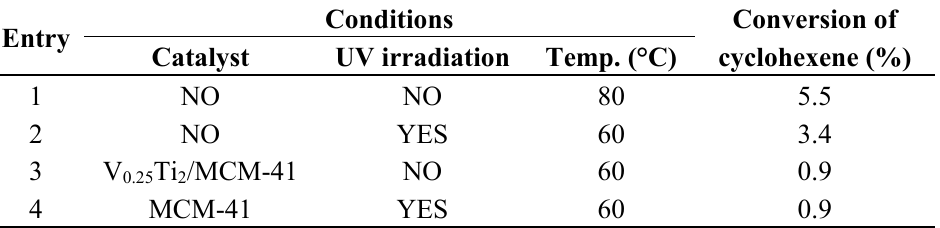
Table 3. Blank test results for cyclohexene